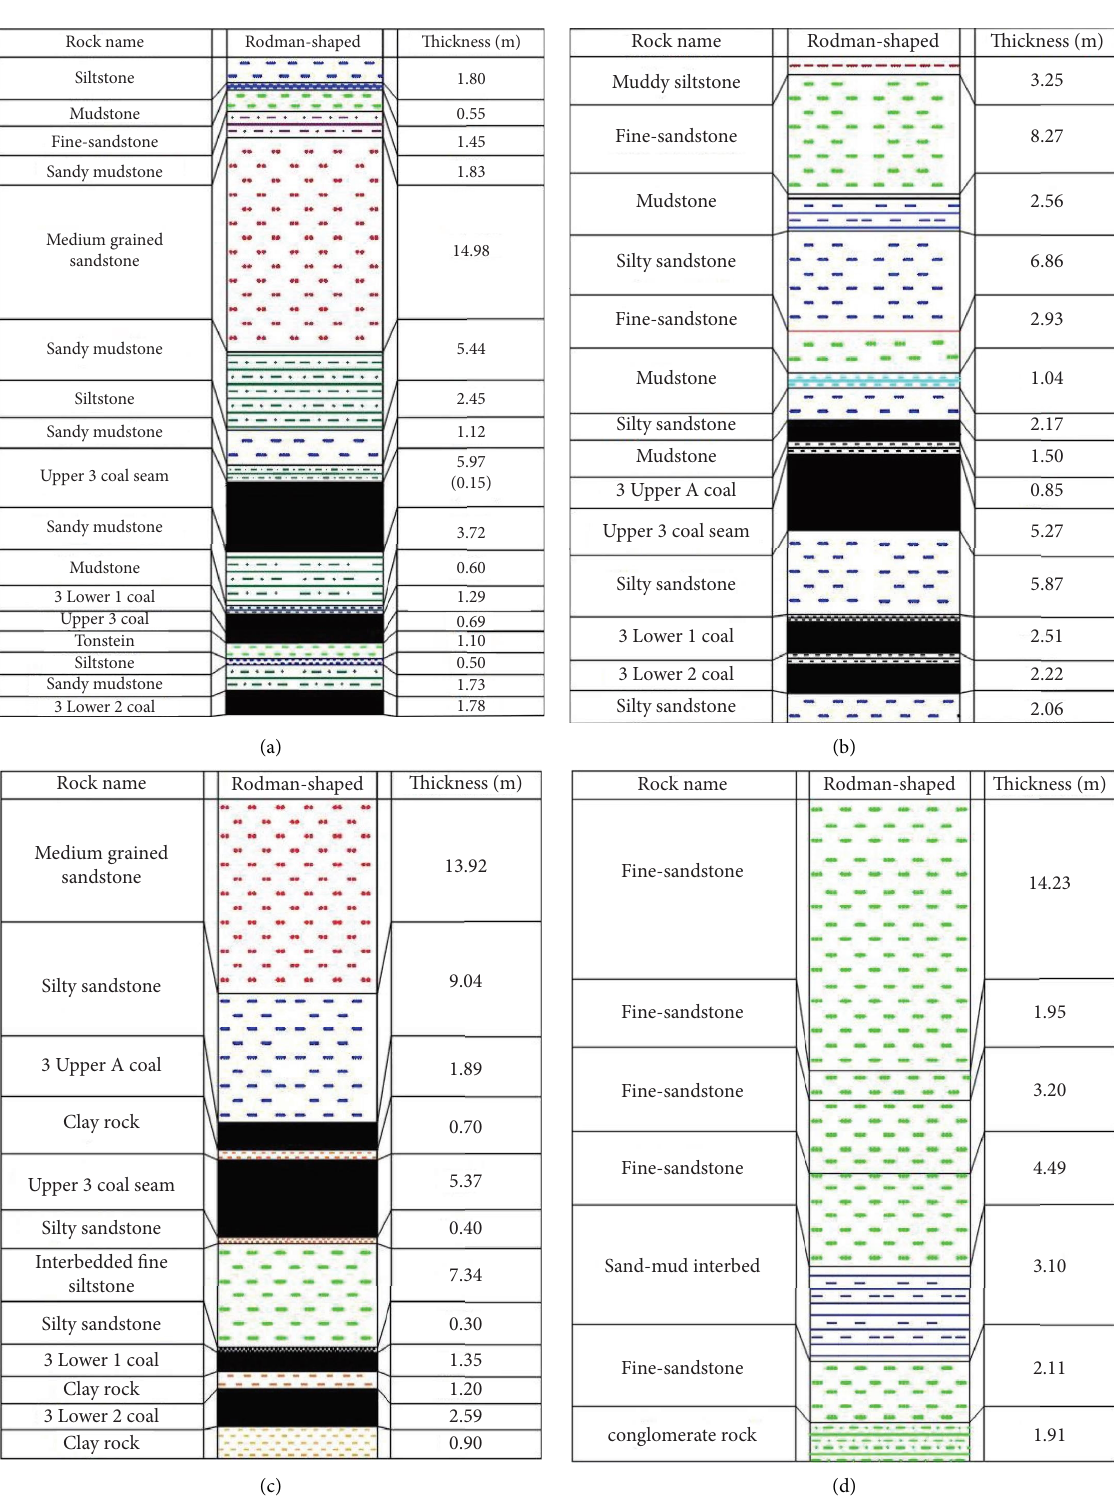
Figure 1: Coal seam columnar section. (a) J 6-2. (b) J 9-3. (c) B 7. (d) B 7 drillhole in a higher